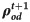
Updatings of the risk attitude parameter ρodt+1 with different values of parameter σ.A larger σ-value corresponds to a larger change rate of ρodt.